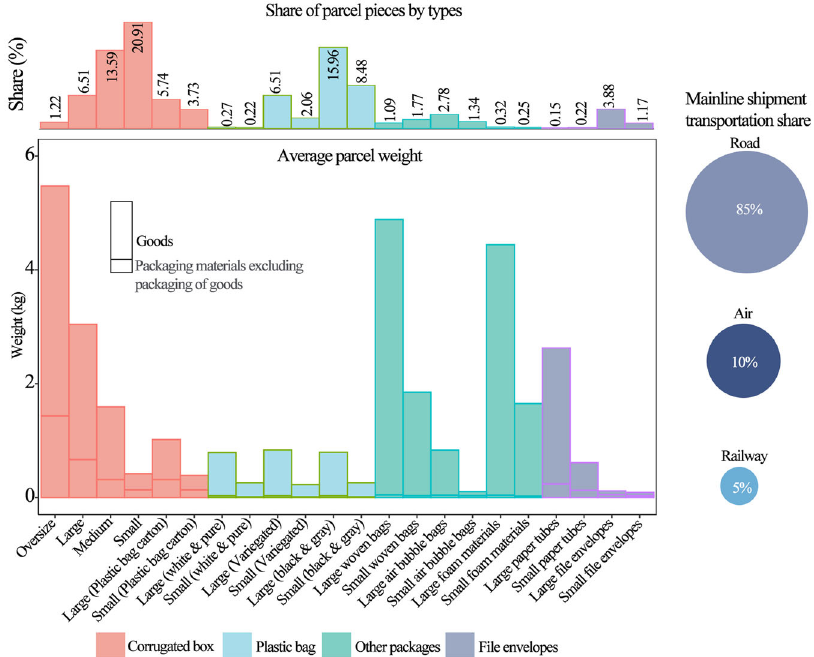
Fig. 1 Express deliveries in China in 2018 by parcel type and transportation mode. Four types of packaging materials of parcels were classi fi ed: corrugated box, plastic bag, fi le envelopes, and other packaging. The ratios of the categories of packaging type were calculated. Sample batches of each packaging material category, of different sizes and materials, were weighed, and the mean values calculated. If divided by sectors, 85%, 10%, and 5% of these parcels were delivered via road, air, and railway transportation,